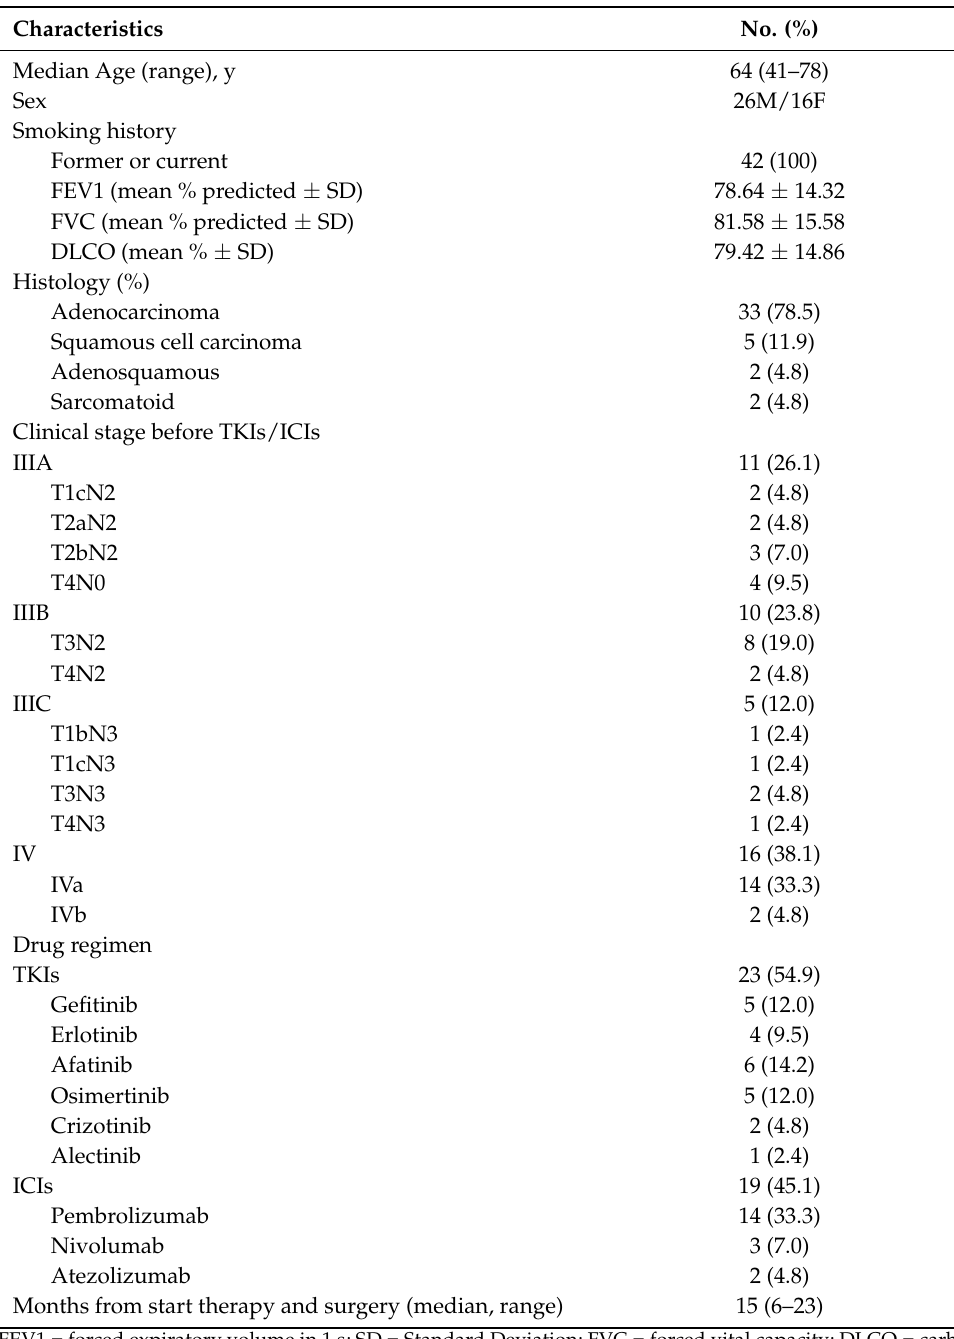
Table 1. Baseline characteristics of the study group ( n =